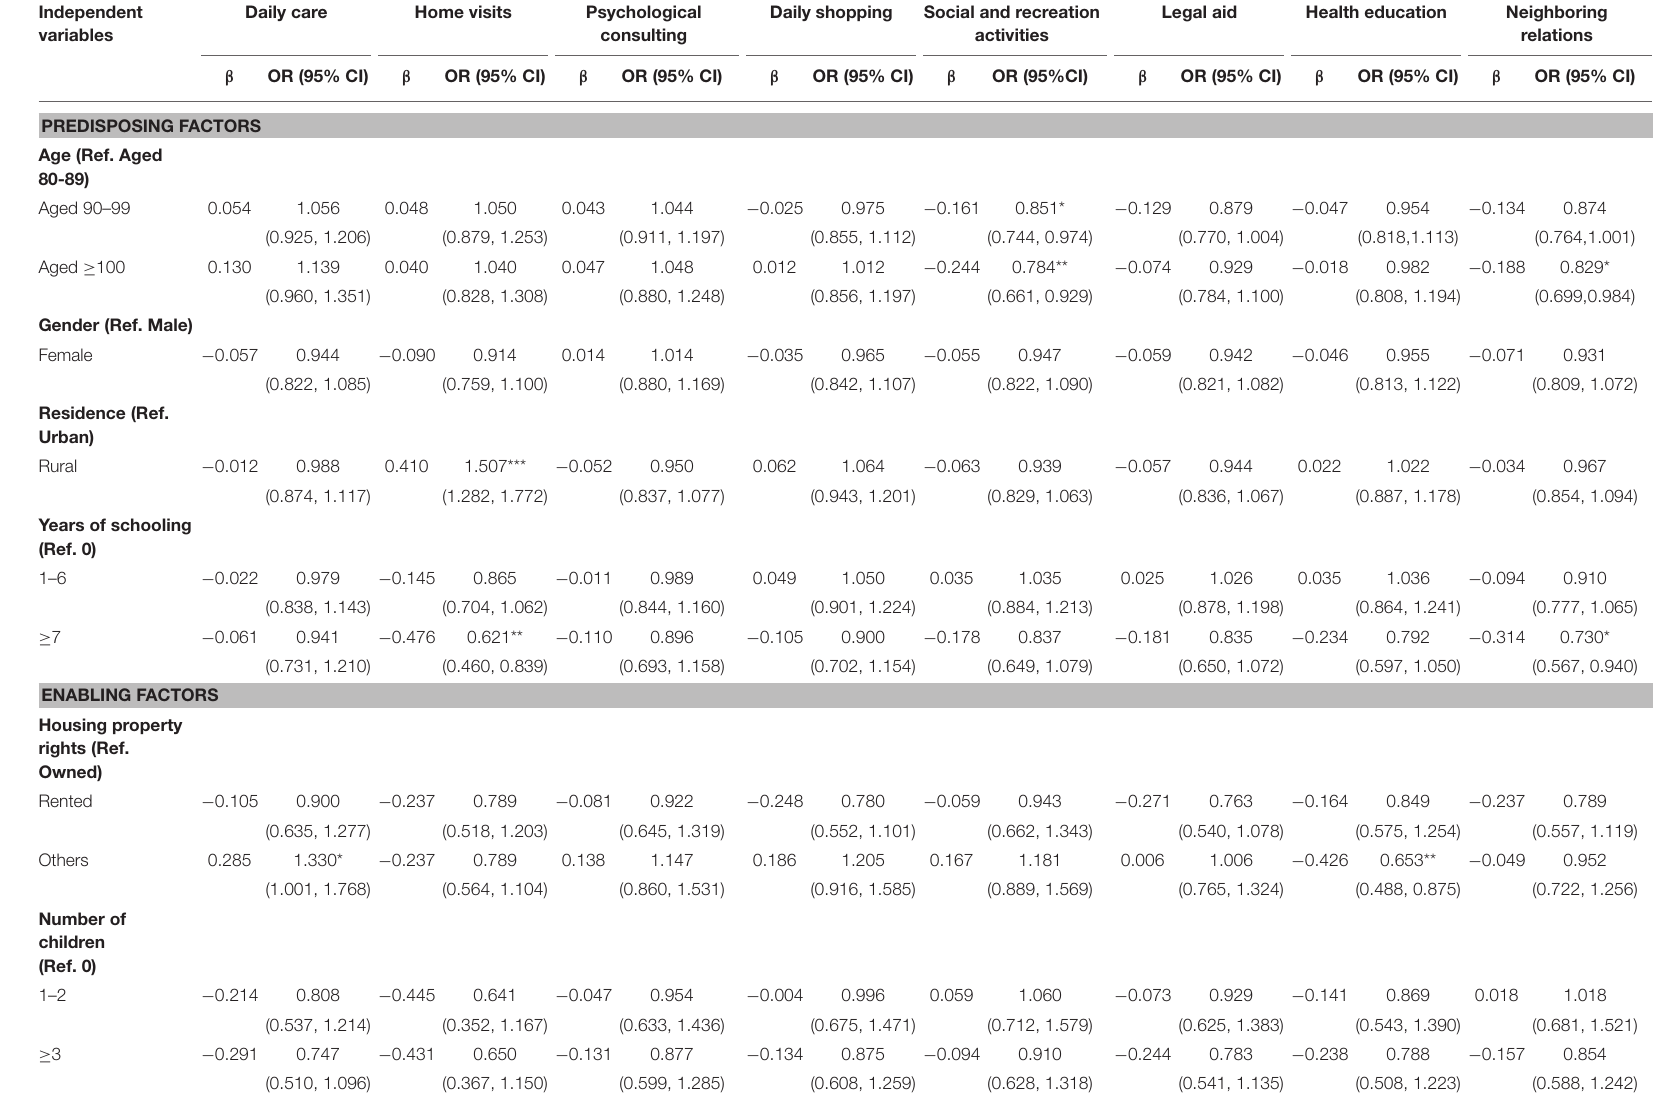
TABLE 3 | Elderly care service demand for the oldest old (binary logistic regression). Independent